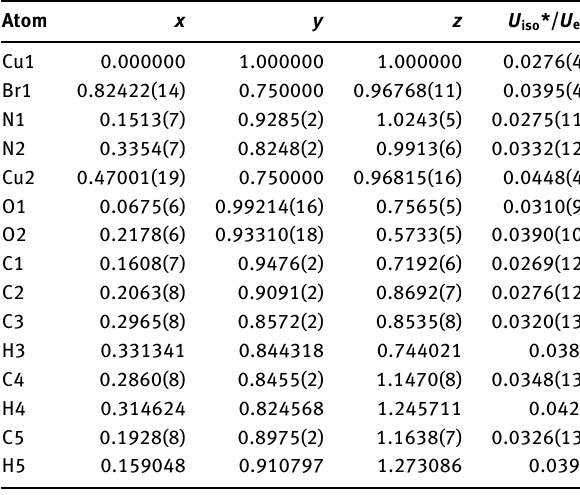
Table 2: Fractional atomic coordinates and isotropic or equivalent isotropic displacement parameters (Å 2